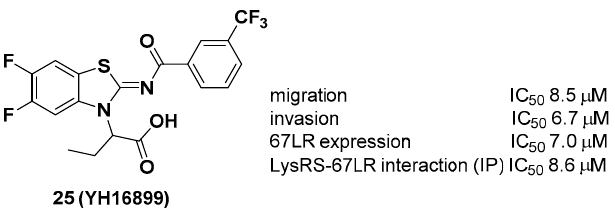
Figure 9. YH16899, a protein–protein interaction inhibitor of LysRS and 67-kDa laminin receptor (67LR).